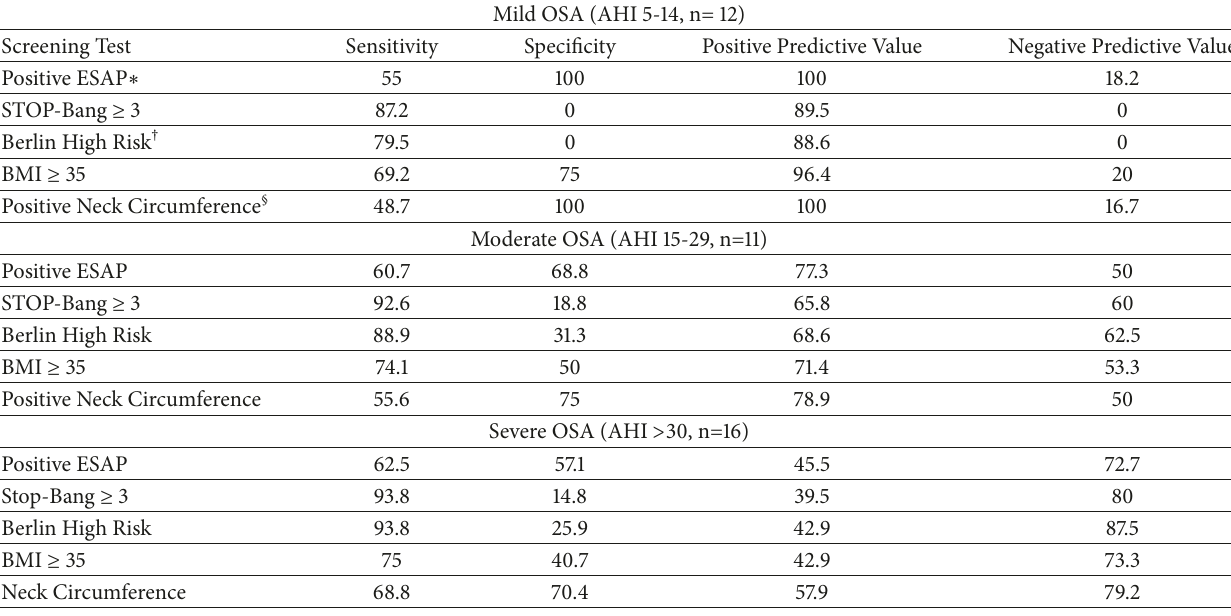
Figure 1: (a) Easy sleep apnea predictor (ESAP) entails placing both thumbs together at the anterior of the neck and encircling the fingers in the posterior. (b) Positive ESAP is shown. The patient is unable to encircle their neck resulting in at least a 1cm gap between fingertips. (c) Negative ESAP is shown. The patient is able to encircle their neck defined as touching fingertips in the posterior neck. Figures reproduced with author permission [17]. Table 2: Comparison of for screening tests for sensitivity, specificity, positive predictive value, and negative predictive value for mild OSA, moderate, and severe